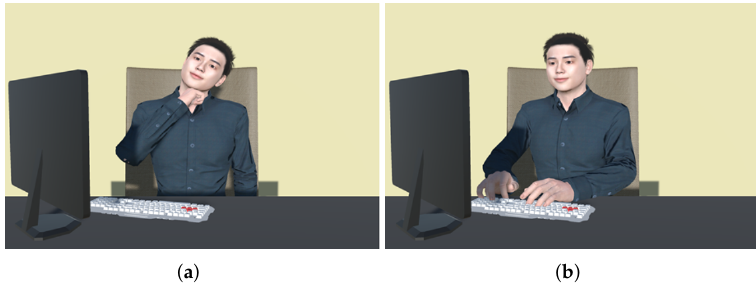
Figure 4. ( a ) The thinking motion and ( b ) typing